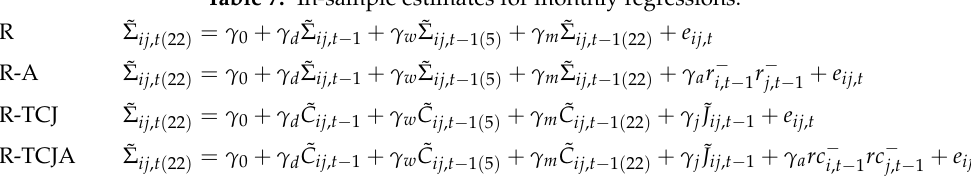
Table 7. In-sample estimates for monthly regressions.